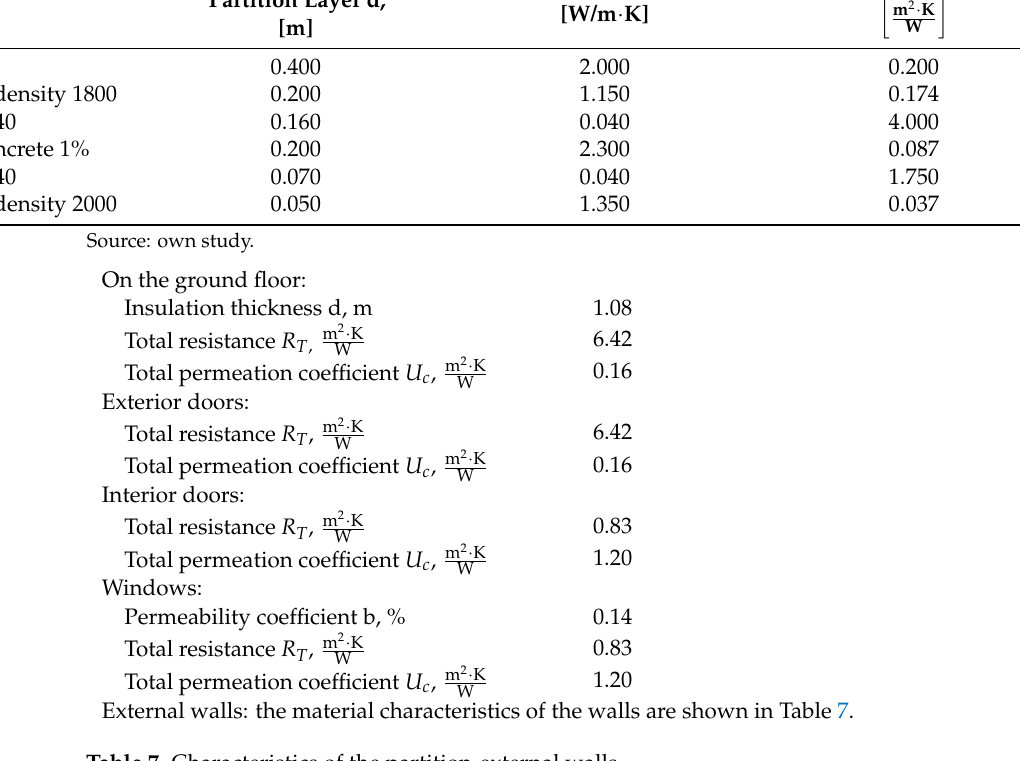
Table 7. Characteristics of the partition-external